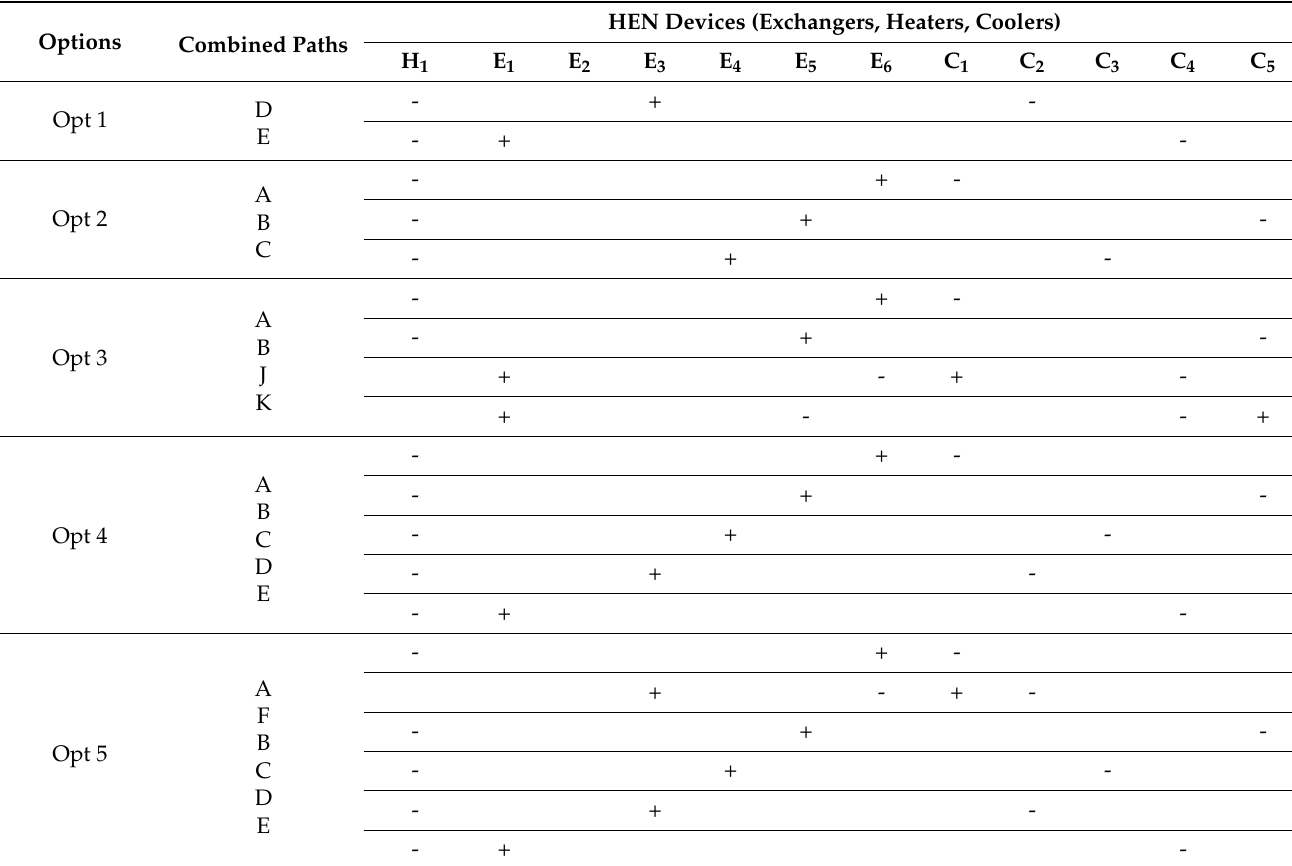
Table 4. The selected combined paths in the HEN